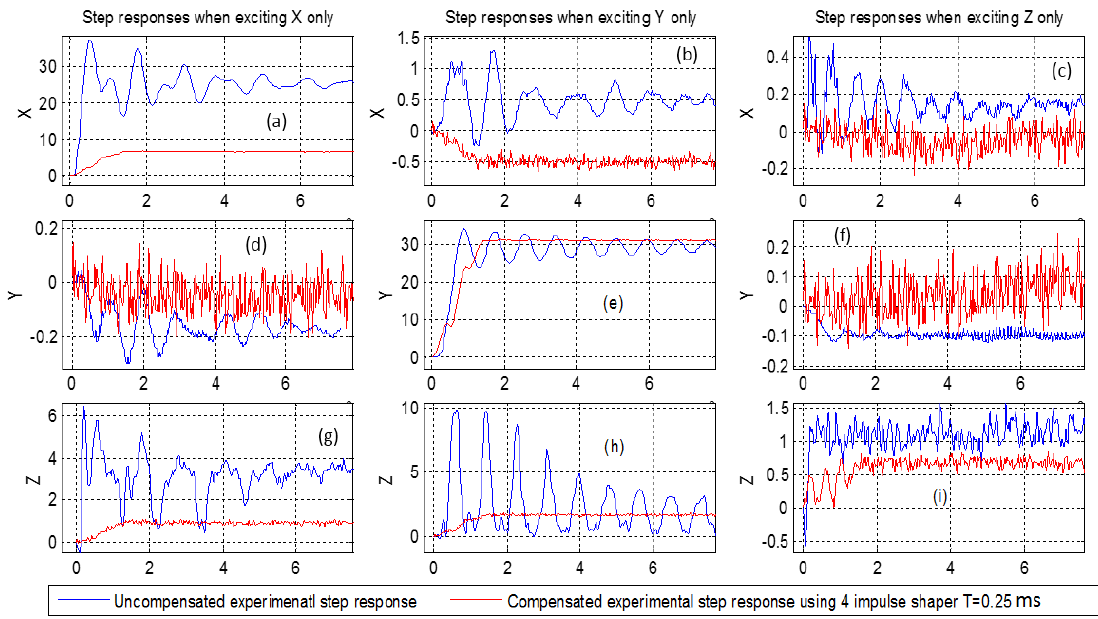
Figure 7. Step responses for the uncompensated and four-impulse compensated responses—